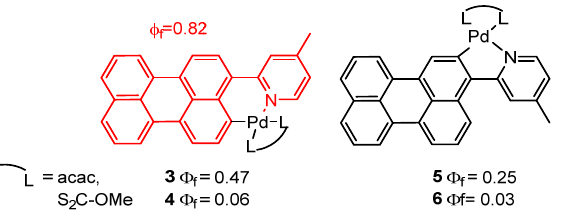
Figure 3. Fluorescence quantum yields of five and six-membered palladacycles. Adapted from [60].